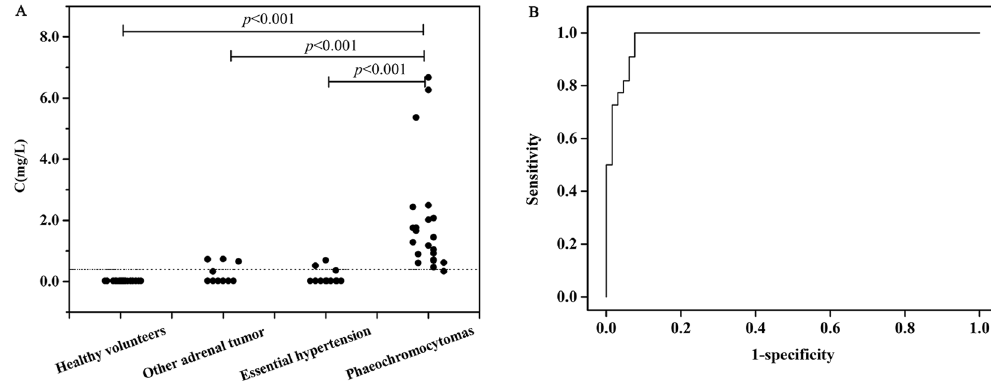
Figure 5. Diagnostic efficacy for detection of PHEO. ( A ) Distribution of free MNs concentrations in spot urine of subjects in this study. ( B ) ROC curves for the diagnostic performance of spot urinary MNs. Dash dotted line, cut-off